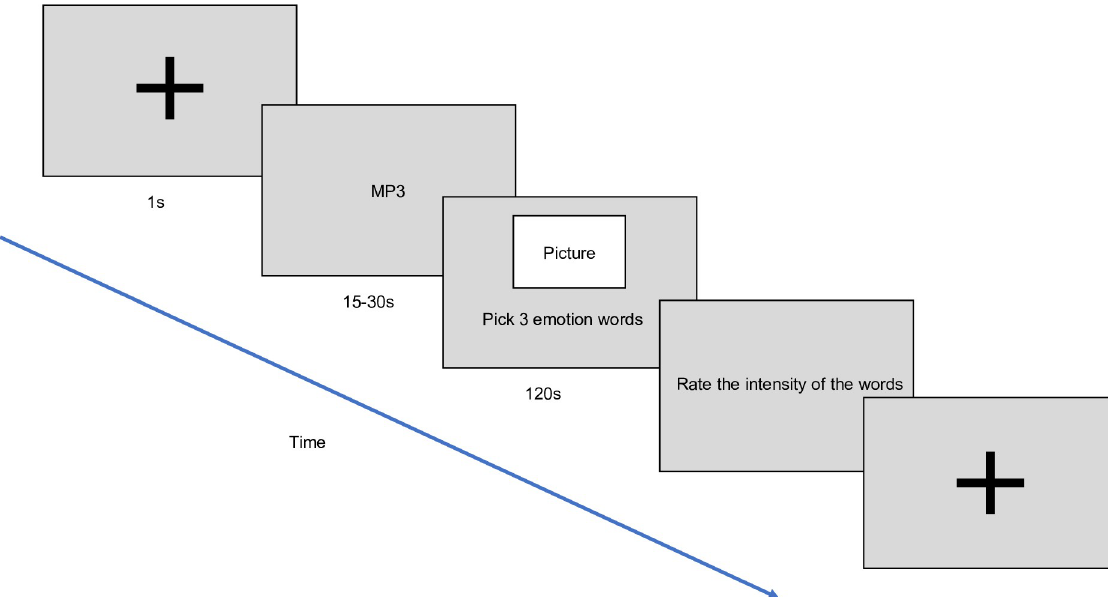
Fig 5. Visual illustration of the progression of each trial.